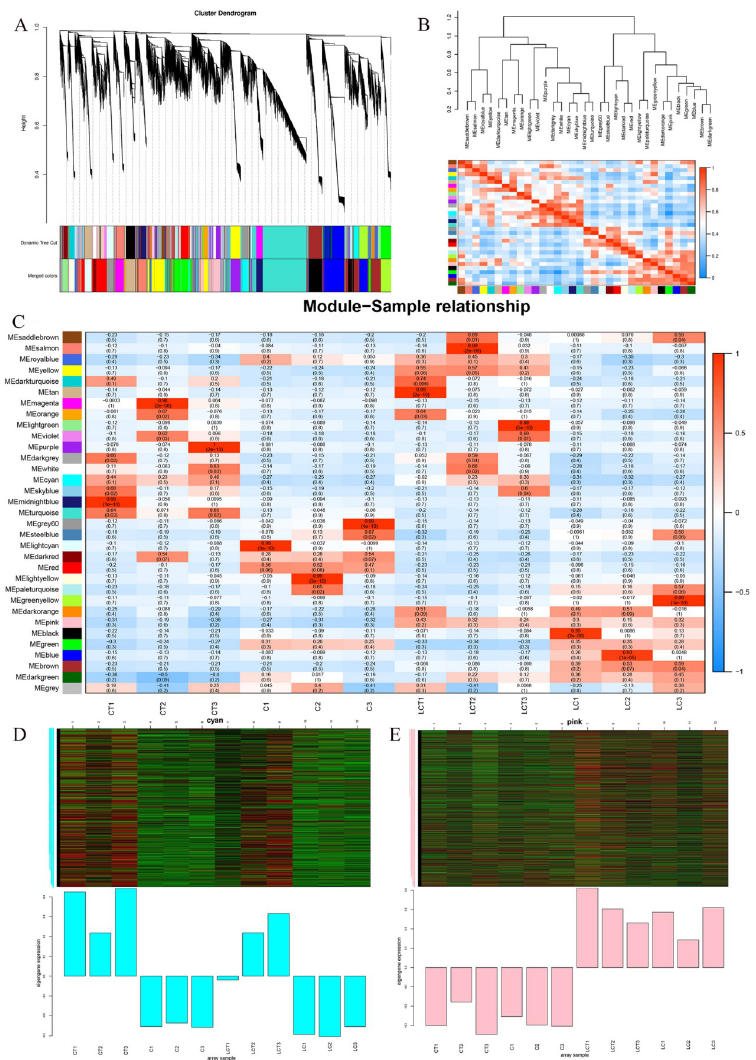
Fig 9. WGCNA analysis. A, Module hierarchy cluster tree diagram; B, Heat map of correlation between modules; C, Sample traits and module-to-module correlation heat map. The horizontal coordinates are samples, the ordinates are modules; D, E, Calorimetric map of gene expression in the